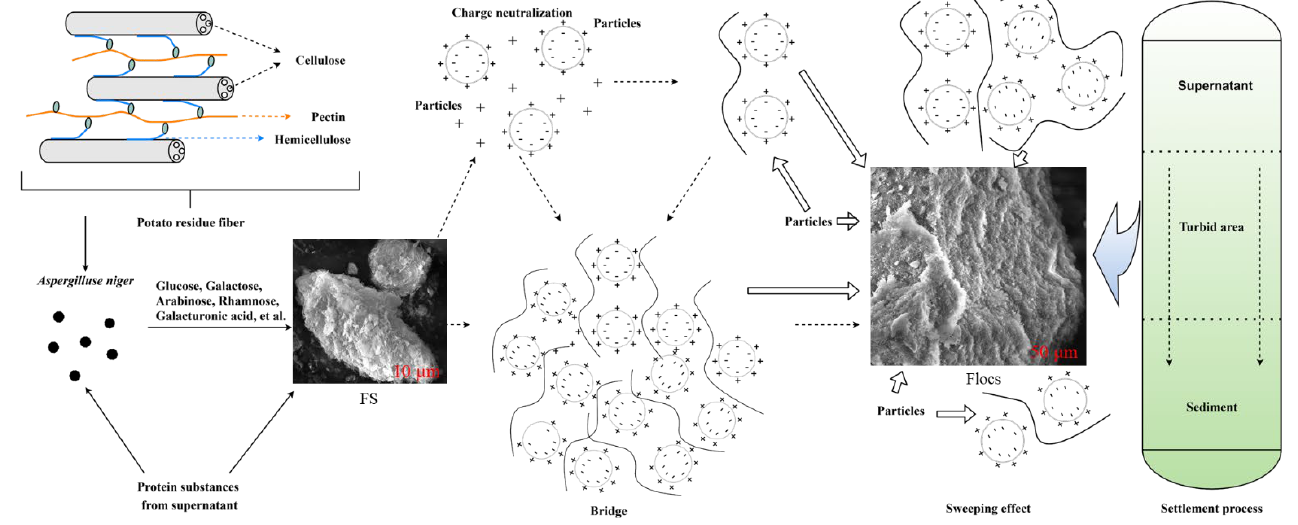
Figure 12. A hypothetical model for the flocculation by A. niger during industrial reutilization of potato starch by-products. The solid black arrows represent the conversion of potato starch by-products by A. niger and the formation of FS. The black dotted arrow represents the putative flocculation mechanistic process. The frame arrow represents the sweeping effect of large flocs by adsorption of surrounding matter.